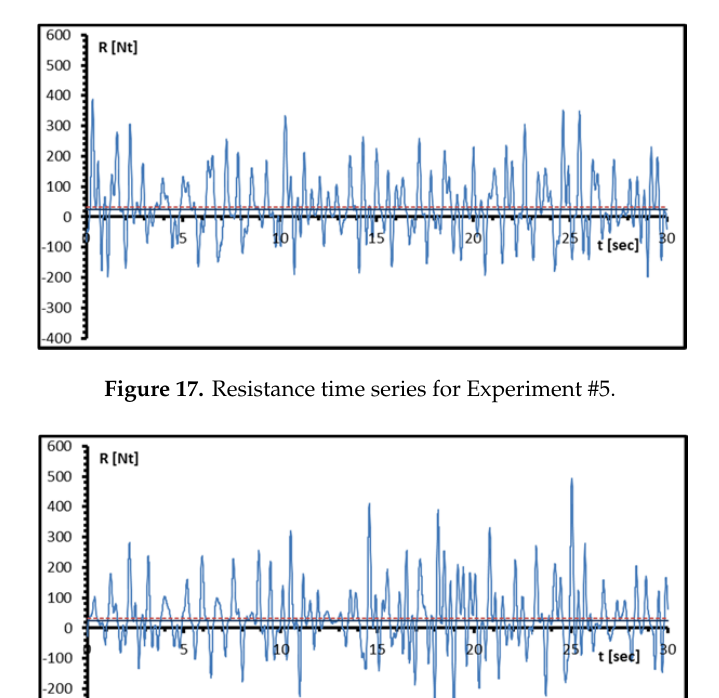
Figure 16. Resistance time series for Experiment #4.